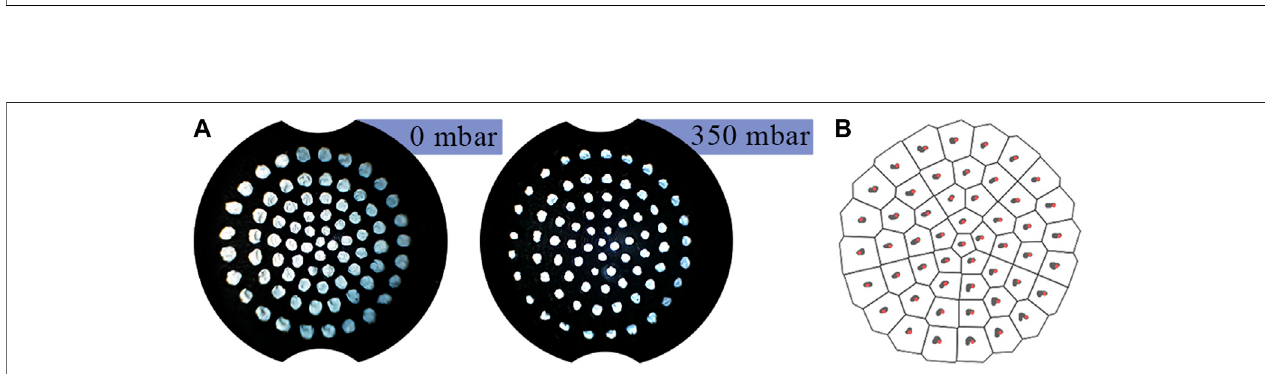
FIGURE 7 | Tactile Voronoi diagram response corresponding to a range of stimuli. Voronoi regions are colored by increasingly dark shades of red or green to display area expansion or contraction respectively. The red arrows from the centroid of each region show the vector displacement of regions from their non-deformed positions.